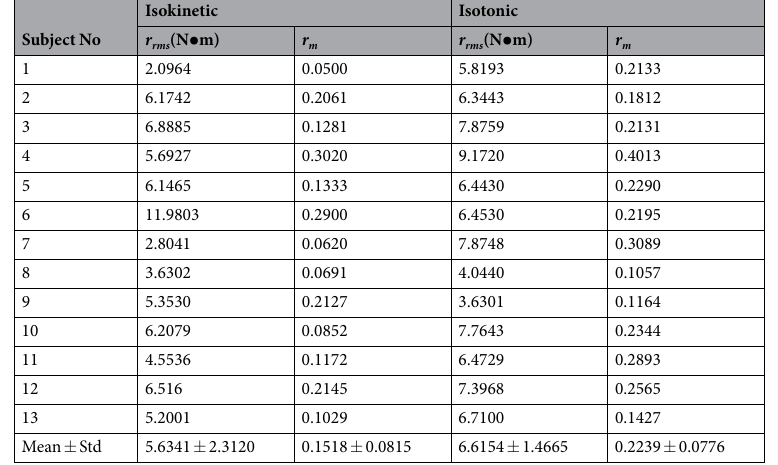
Table 2. Errors of estimation ( r rms and r m ) in isokinetic and isotonic